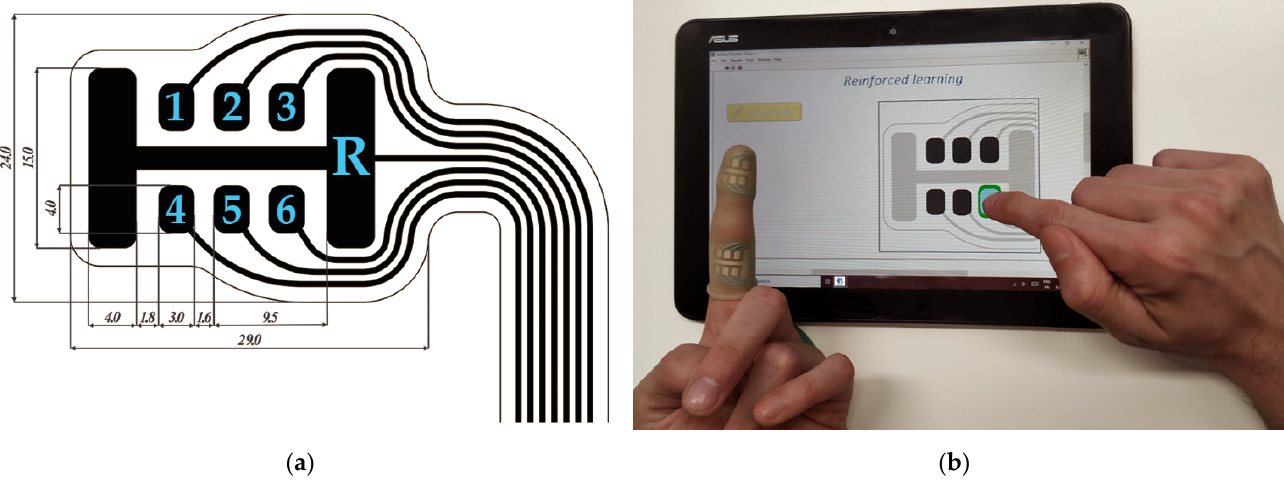
Figure 1. ( a ) Technical drawing of the multi-pad electrode for electrotactile stimulation of a finger phalanx with labelled dimensions in millimeters and pad numeration for active electrodes; ( b ) A subject performing the experiment. The image shows two electrodes positioned on the proximal and distal phalanx of the index finger (non-dominant hand). The electrodes were secured with a transparent silicone cover. The dominant hand was used to control the custom-designed LabView application on the touch-screen tablet PC.